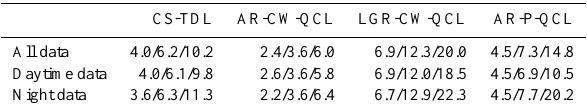
Table 3. Statistics of spectral corrections of fluxes as percentage of raw uncorrected fluxes: lower percentile/median/upper percentile. Based on flux measurements during the period DOY 206–271 (pe- riod II) and data classified as qualified (Table 4). Daytime was de- fined by the elevation of sun higher than zero and night-time lower than zero, respectively. Statistics were derived for data when mea- surements were available for all four